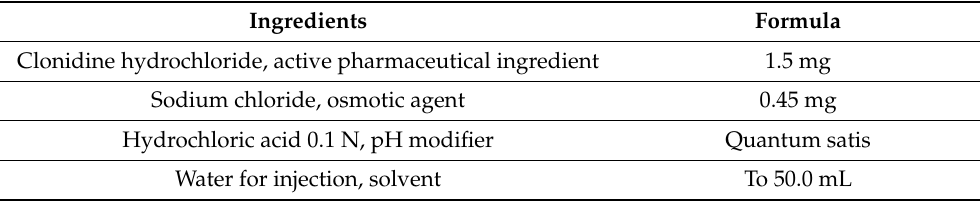
Table A1. Composition of Clonidine hydrochloride 30 µ g/mL produced by Pharmacy Department Erlangen University Hospital, Erlangen, Germany. The ingredients of the drug are identical to the ingredients of Paracefan ® , Catapressan ®